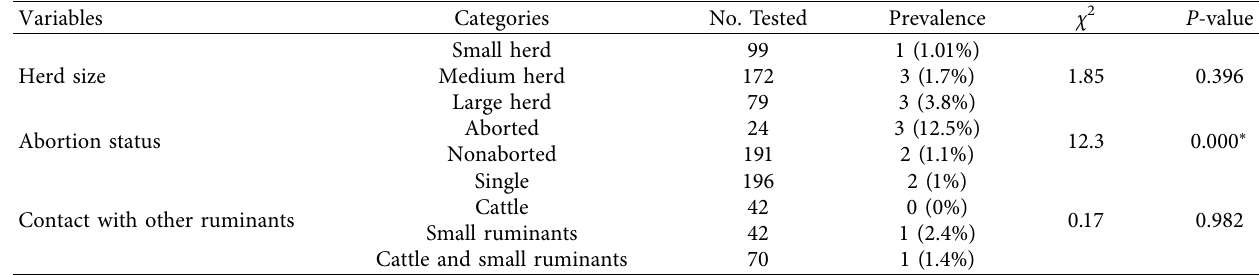
∗ Significantly Table 4: Seroprevalence of camel brucellosis based on abortion status, herd sizes, and contact with other ruminants using CFT as confirmatory.